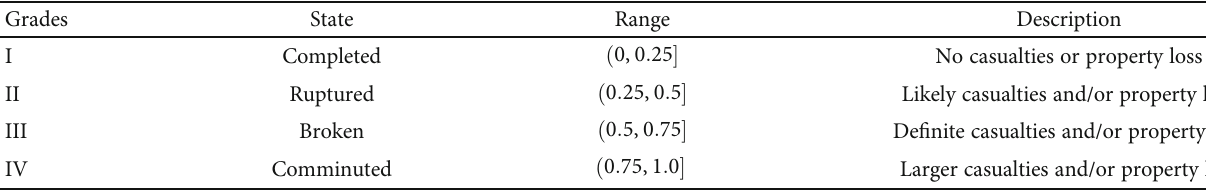
Table 1: Vulnerability classi fi cation